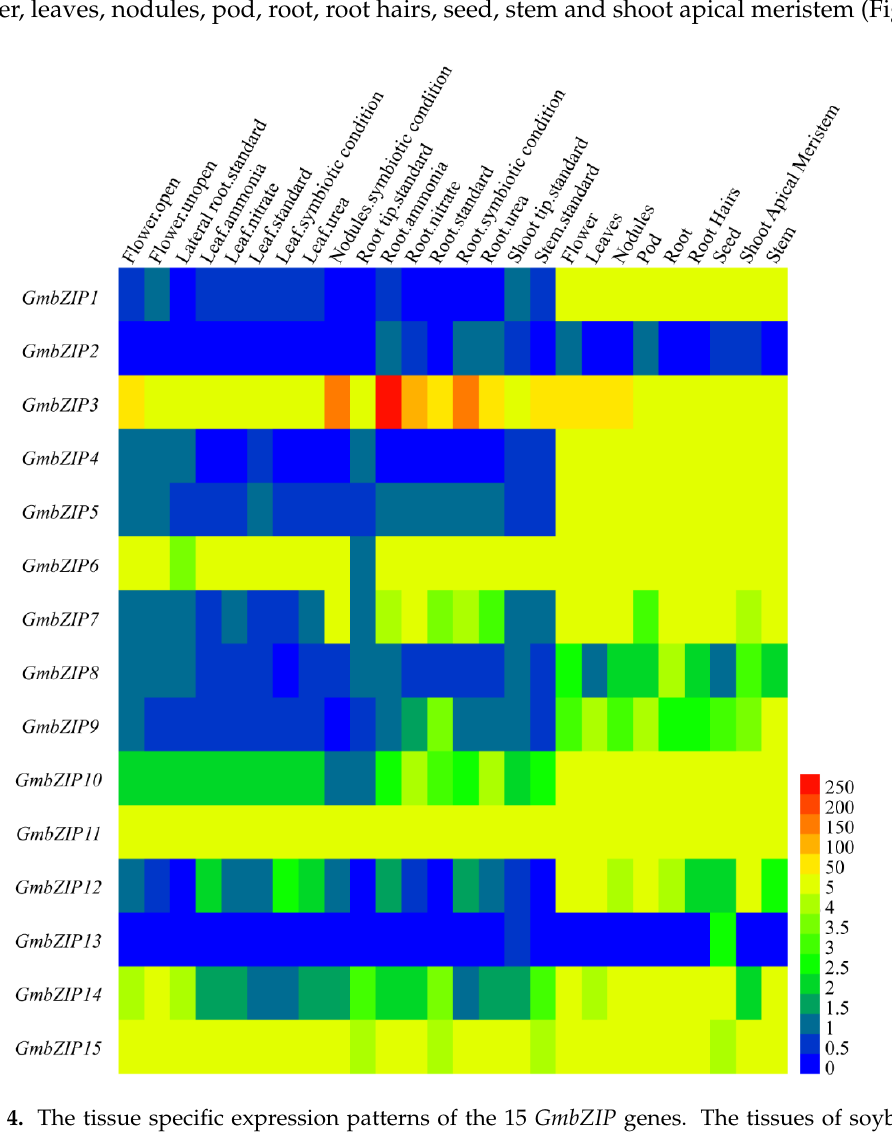
Figure 4. The tissue specific expression patterns of the 15 GmbZIP genes. The tissues of soybean from left to right are flower open, flower unopen, lateral root standard, leaf ammonia, leaf nitrate, leaf standard, leaf symbiotic condition, leaf urea, nodules symbiotic condition, root tip standard, root ammonia, root nitrate, root standard, root symbiotic condition, root urea, shoot tip standard, stem standard, flower, leaves, nodules, pod, root, root hairs, seed, shoot apical meristem and stem organs. The color legend refers to the di ff erent expression levels under normal